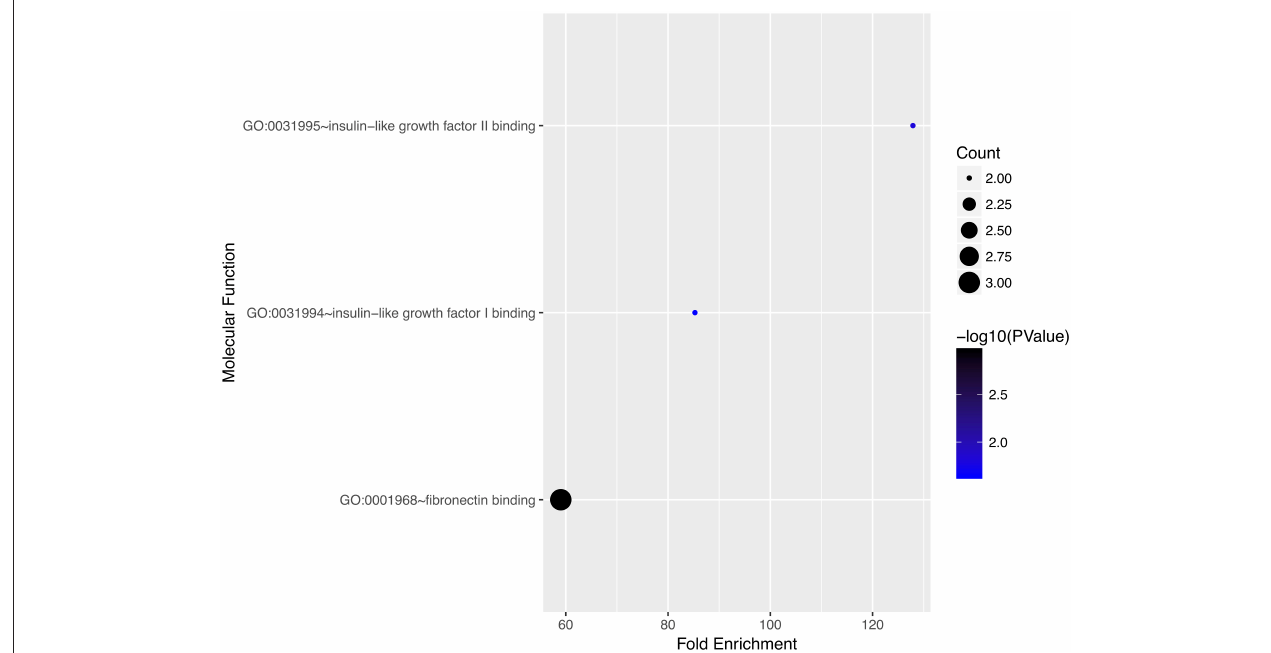
FIGURE 4 | Gene ontology analysis for molecular function of genes involved in the ceRNA network in ACC.